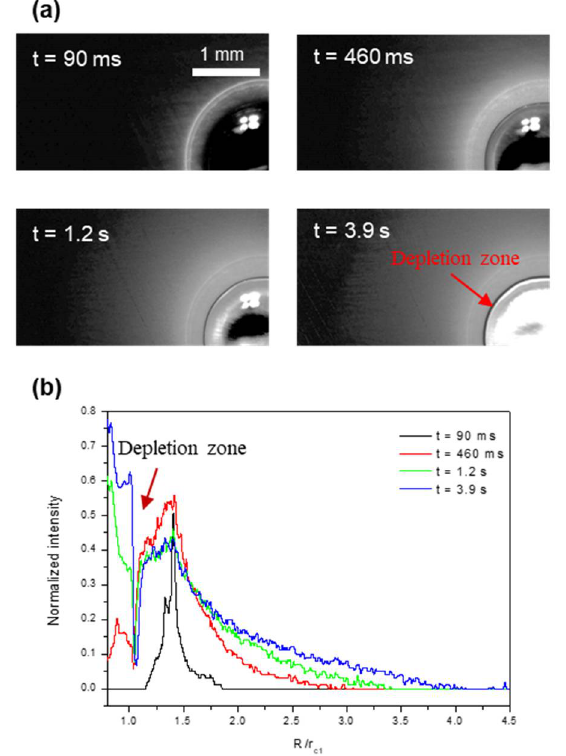
Figure 5. Growing dynamics of the condensate/frost region ( a ) and the resultant intensity profiles ( b ) at the substrate temperature of T s = −15.4 ± 0.2 °C.